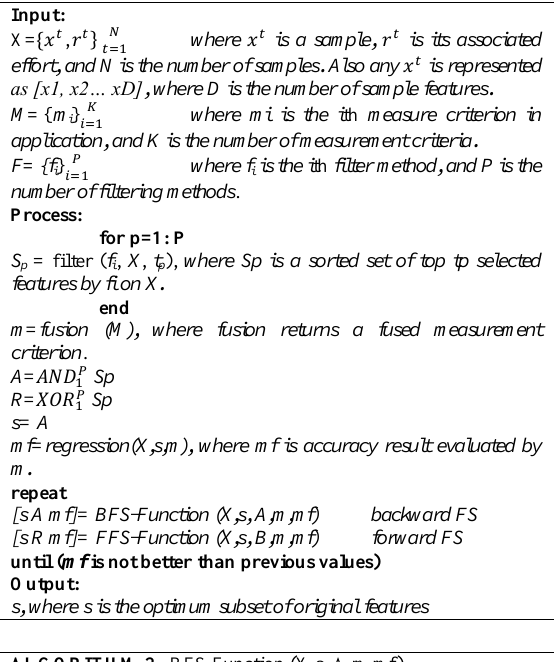
ALGORITHM 2. BFS-Function (X,s, A,m,mf)